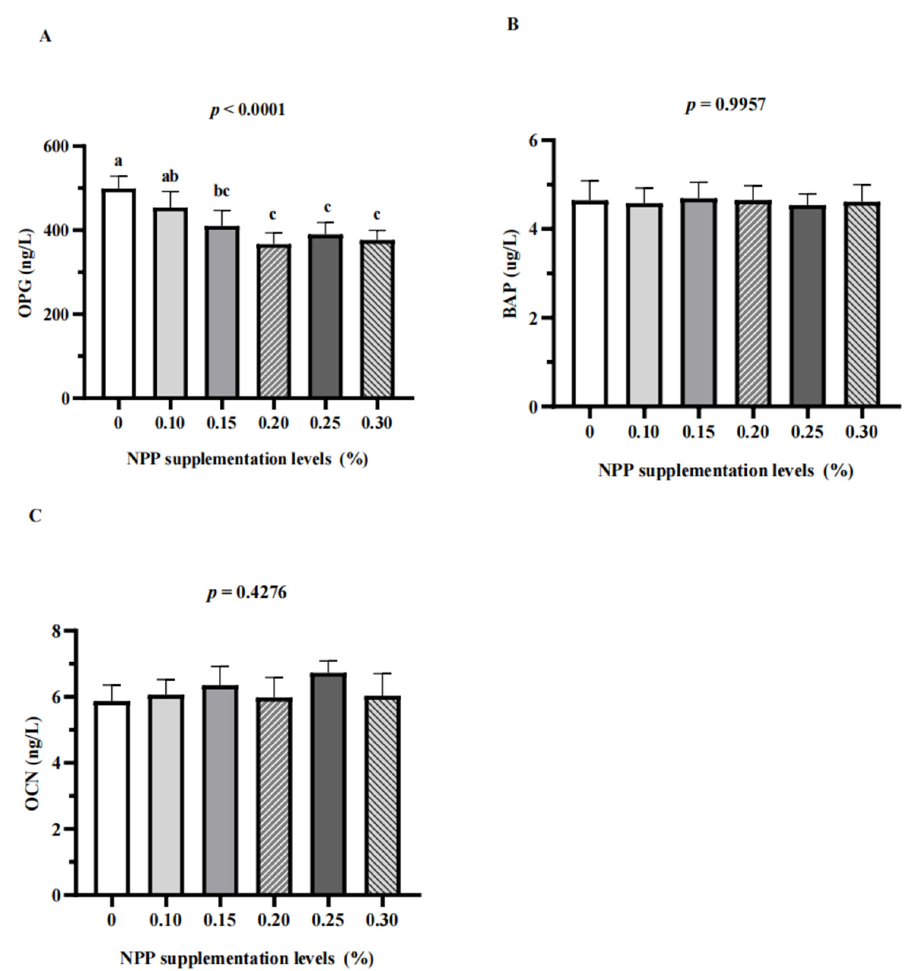
Figure 3. Effect of the level of dietary NPP supplementation on the serum bone formation markers of Hy-Line Brown laying hens (69–78 weeks of age) fed a phytase-containing diet. OPG = osteoprotegerin ( A ); BAP = bone alkaline phosphatase ( B ); OCN = osteocalcin ( C ). a–c Mean values within one row lacking a common superscript differ ( p < 0.01). The statistical unit was each hen ( n = 10; at the end of feeding, two hens per replicate were selected randomly for sample collection).